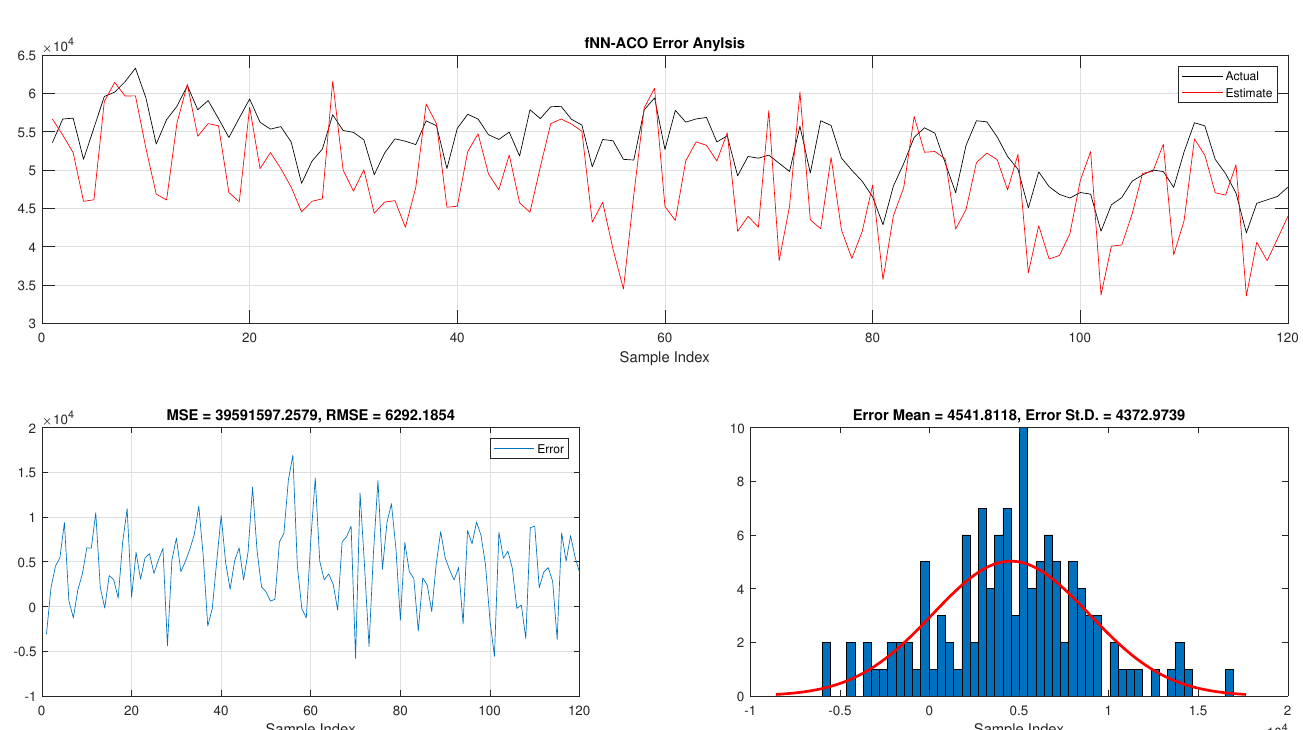
Figure 18. Error analysis of the total daily load consumption with fNN-ACO best results.